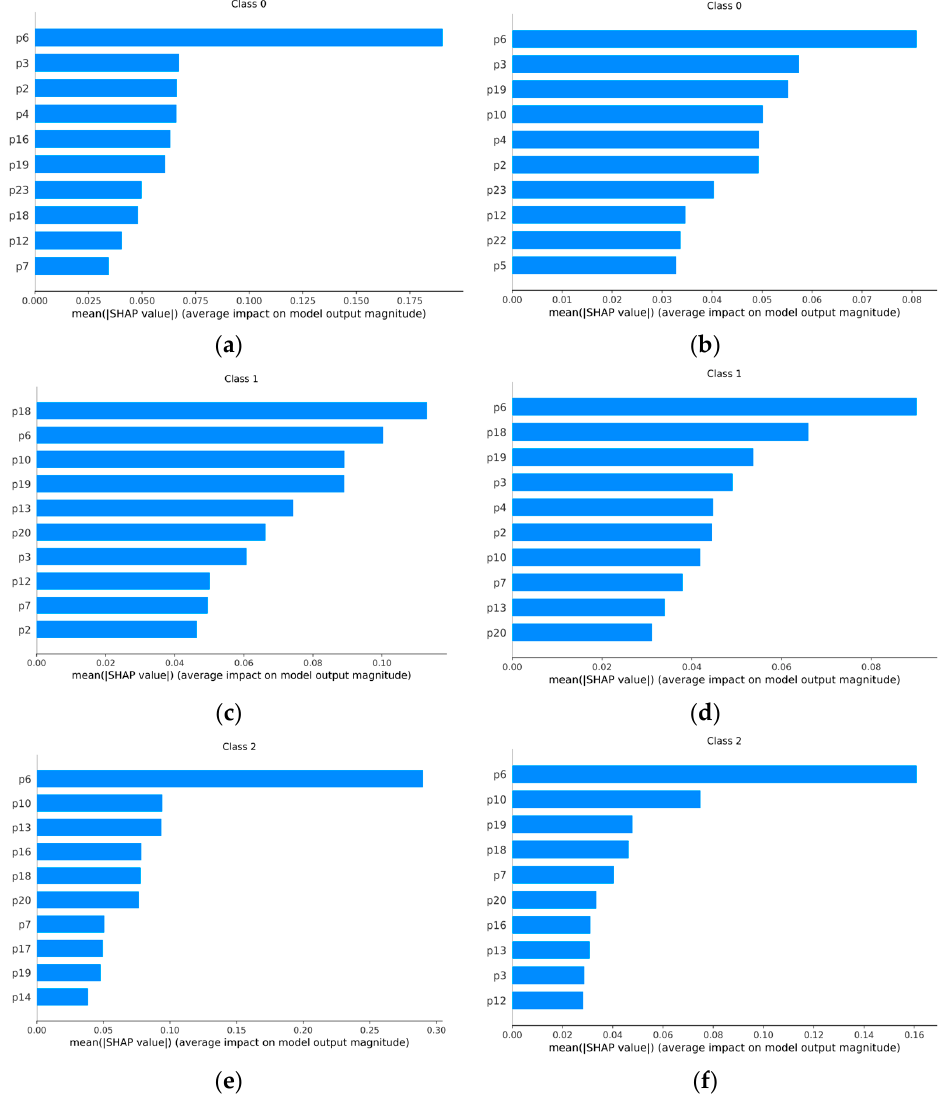
Figure 7. Mean SHAP values: ( a ) SVM mean Shapley values for class 0 (normal); ( b ) kNN mean Shapley values for class 0 (normal); ( c ) SVM mean Shapley values for class 1 (IR damage); ( d ) kNN mean Shapley values for class 1 (IR damage); ( e ) SVM mean Shapley values for class 2 (OR damage); and ( f ) kNN mean Shapley values for class 2 (OR damage).